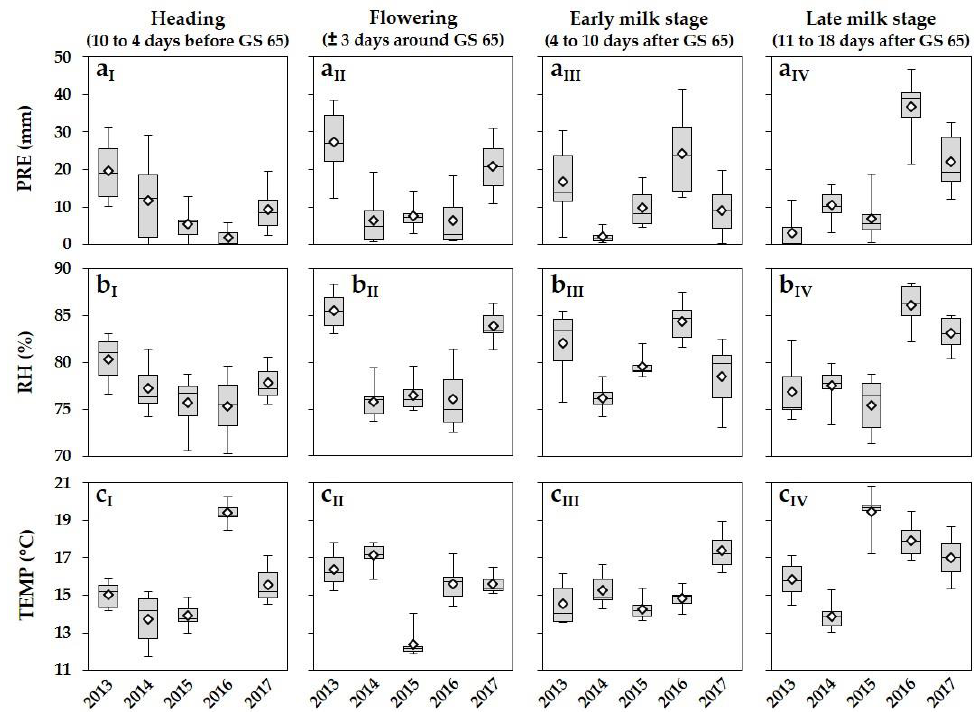
Figure 2. Boxplots and means (white rhombus) of meteorological variables ( a ) PRE (cumulative precipitation, mm), ( b ) RH (relative humidity, %) and ( c ) TEMP (mean temperature, °C) 10 to 4 days before GS 65 (heading; I), ± 3 days around GS 65 (flowering; II), 4 to 10 days after GS 65 (early milk stage; III) and 11 to 18 days after GS 65 (late milk stage; IV) of wheat of the seven trial locations in northern Germany from 2013 to 2017. Five statistics are represented in each boxplot from bottom to top: the smallest observation, lower quartile, median, upper quartile, and largest observation, respectively.